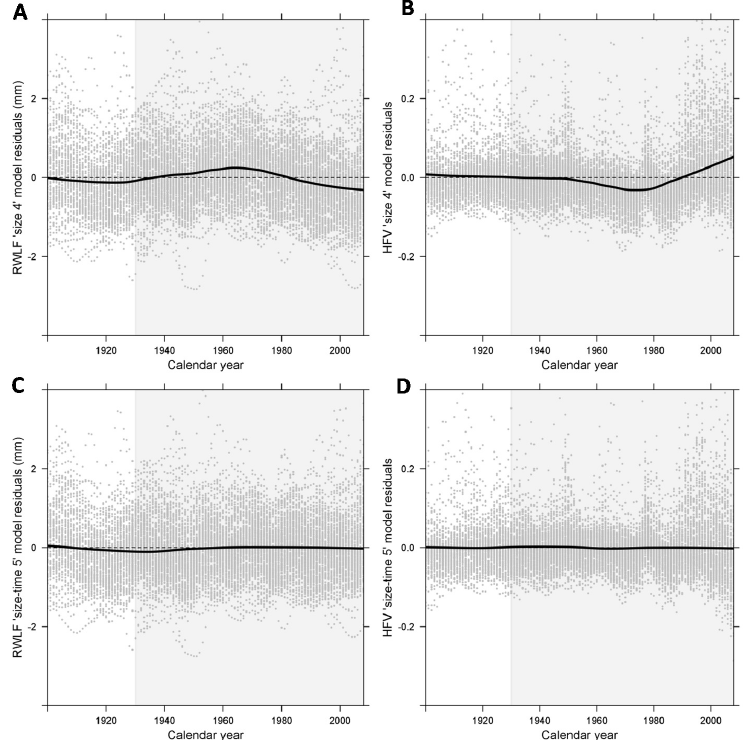
Figure 4. Residuals (grey dots) over time of the “size 4” models ( A , B ) and “size-time 5” models ( C , D ) of ring-width low frequency ( RWLF , A , C ) and high-frequency variability ( HFV , B , D ). Darker areas indicate the period 1930–2008, common to all trees. Lines indicate mean trends (LOESS). The inclusion of the time-dependent effects improved greatly the distribution of residuals over time. Table 1. Synthesis of the modeling steps of the ring ‐ width low frequency models ( (cid:1844)(cid:1849)(cid:1838)(cid:1832) , top) and the high ‐ frequency variability models ( (cid:1834)(cid:1832)(cid:1848) , bottom). Ring ‐ Width Low Frequency ( (cid:2174)(cid:2179)(cid:2168)(cid:2162) ) Models